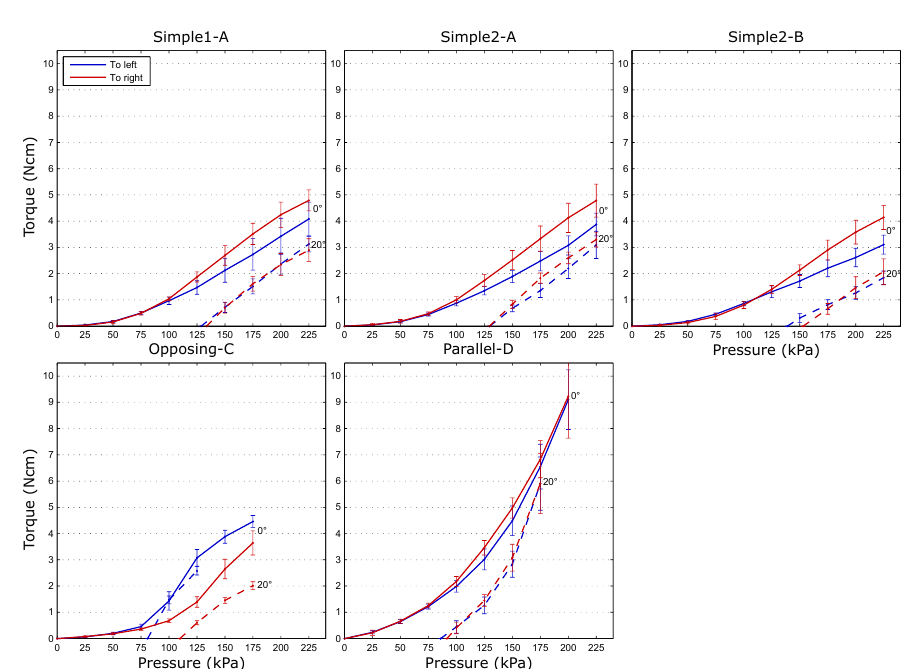
Figure 9. Torque measurement results for abduction-adduction at 0 ◦ and 20 ◦ angles, with sample standard deviations. Maximum pressure for Opposing-C was limited to reduce the ballooning of the pockets and in the end, because of the right side pockets’ excessive ballooning. For Parallel-D, the limitation was due to the actuator starting to twist in unwanted directions, which can be seen also as a notable increase in the standard